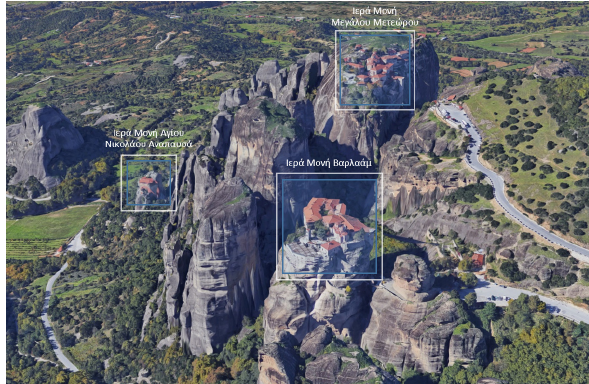
Figure 9. Search for points of interest on the map via the METEORA